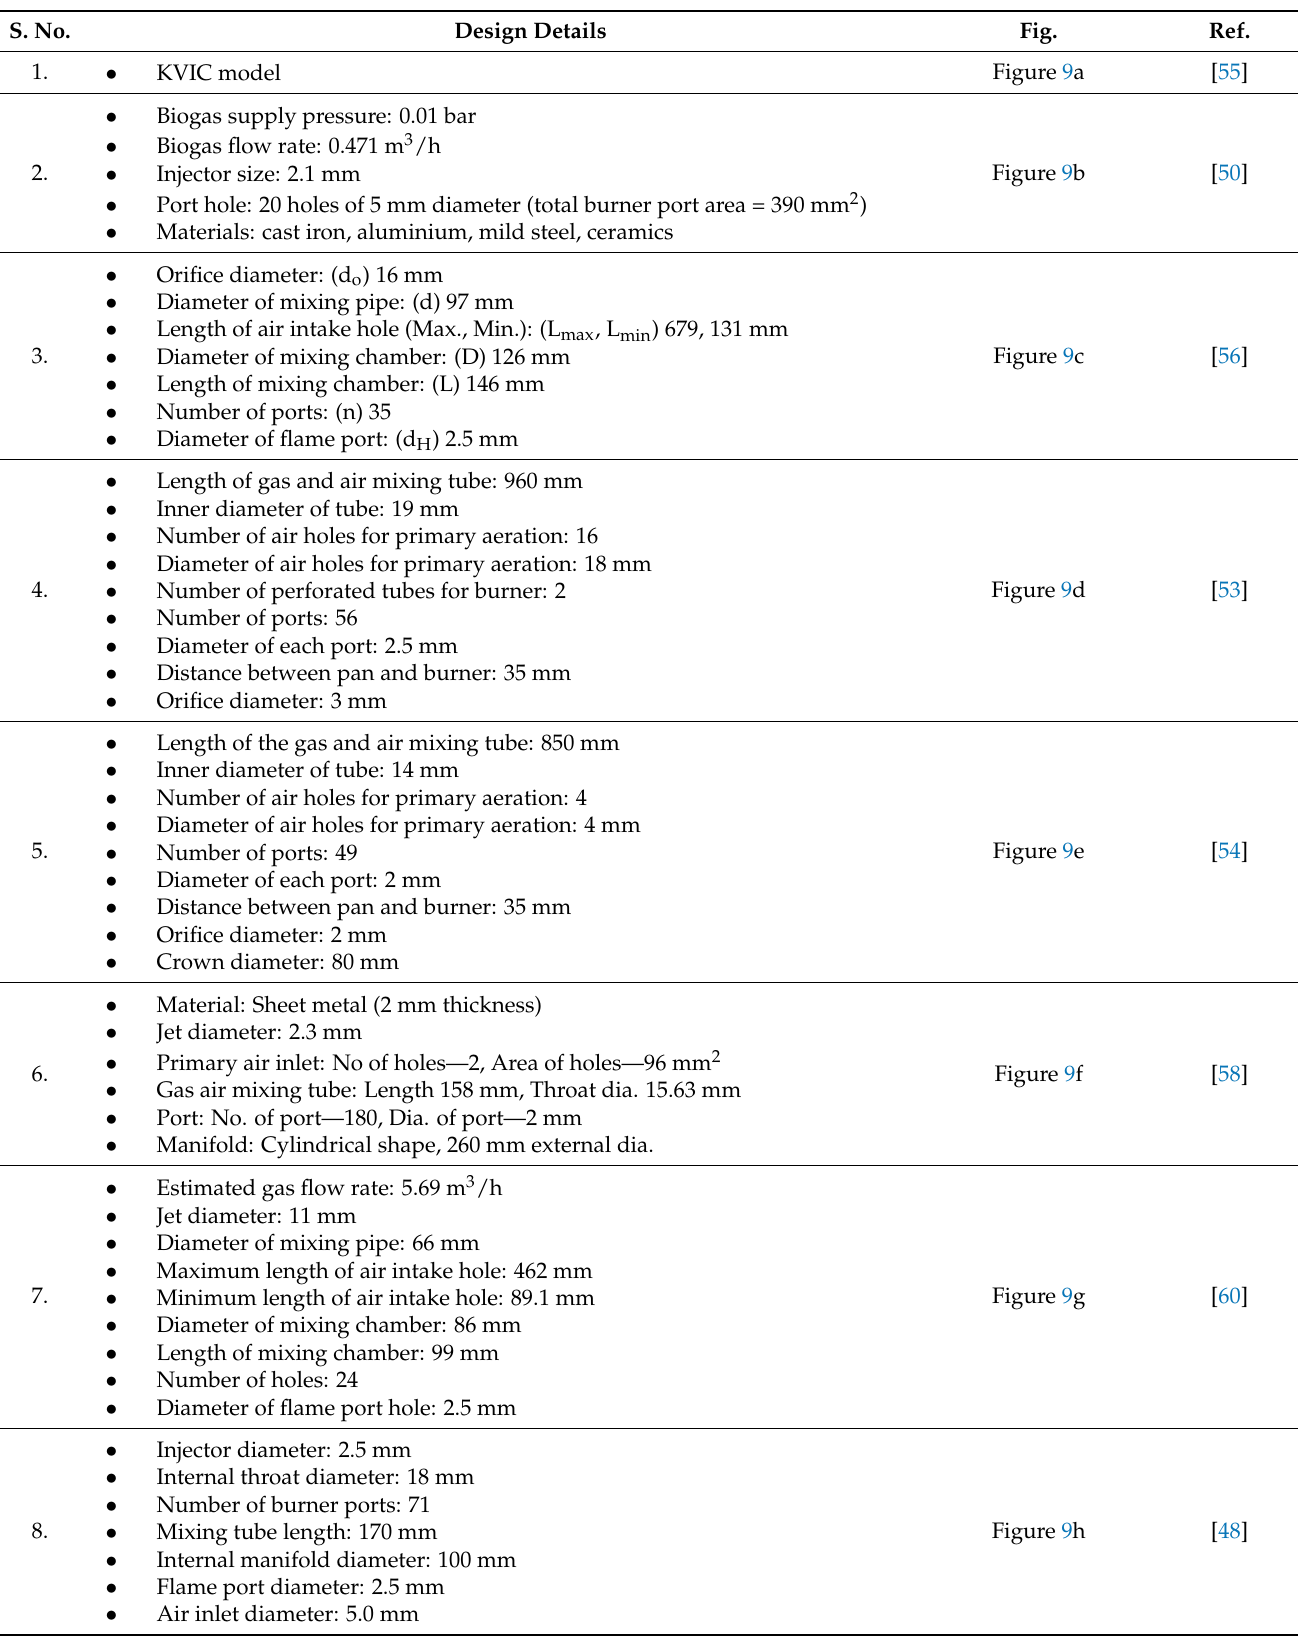
Table 2. Design features of biogas